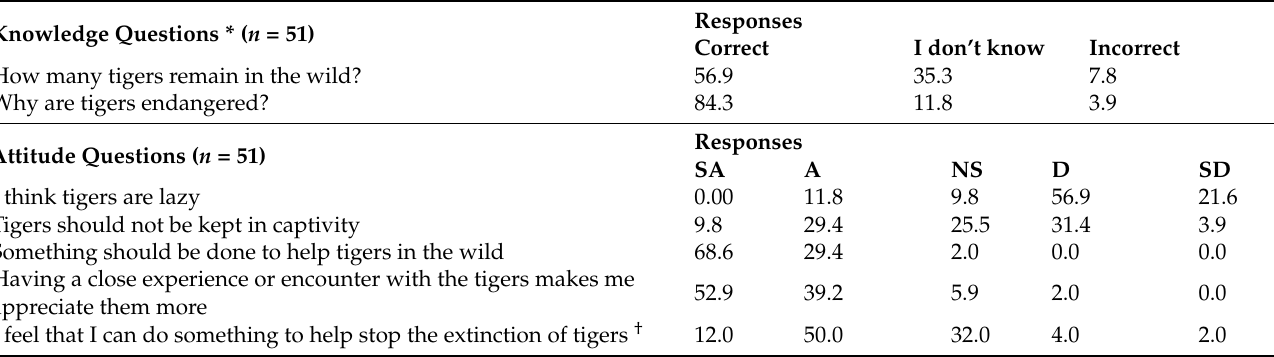
Table 2. Results of the survey administered to groups visiting Fota Wildlife Park who participated in the interactive tiger experience, represented as the percent of respondents to choose each response